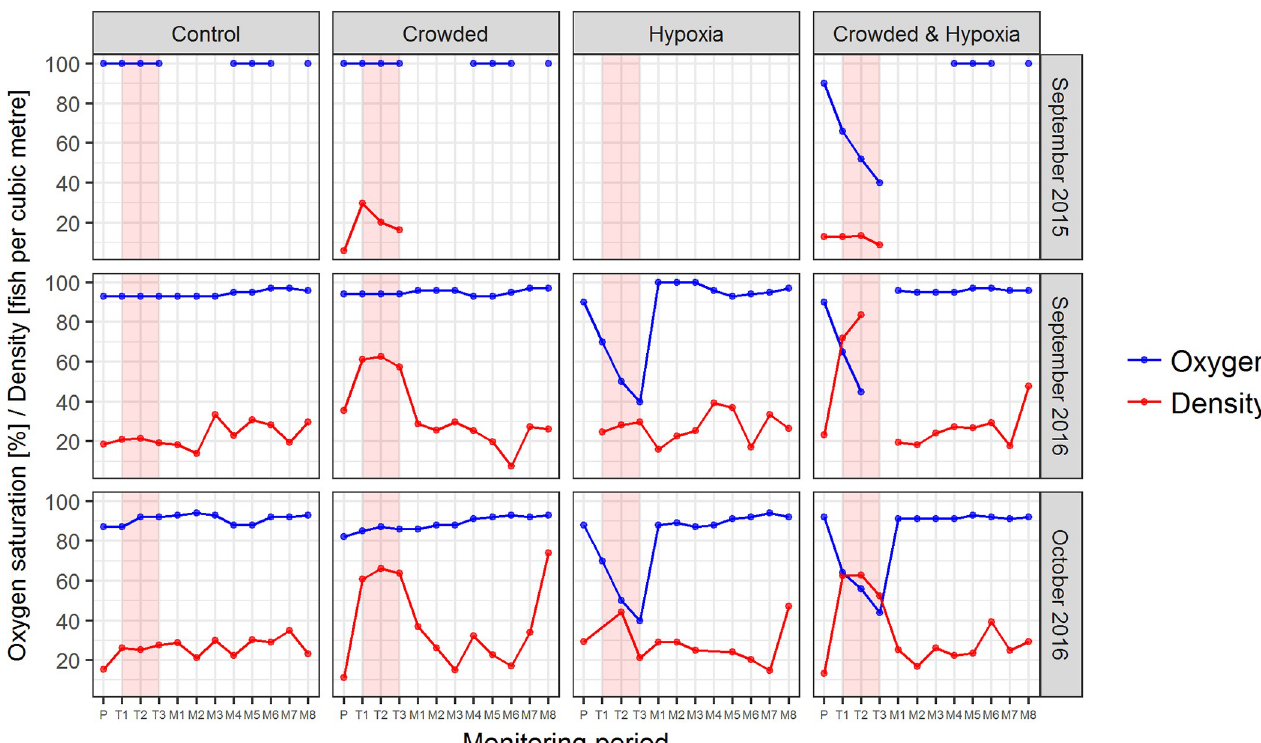
Fig 2. Crowding and hypoxia treatments. Oxygen (dissolved oxygen saturation, blue line) and crowding (fish density, red line) conditions throughout monitoring periods during different stressor treatments, for the three experimental phases. The red shaded area indicates the monitoring periods corresponding to the application of the stressor. For the September 2015 phase, no hypoxia treatment was applied and no density estimates were collected in the post-treatment monitoring periods or at any point during the control treatment.